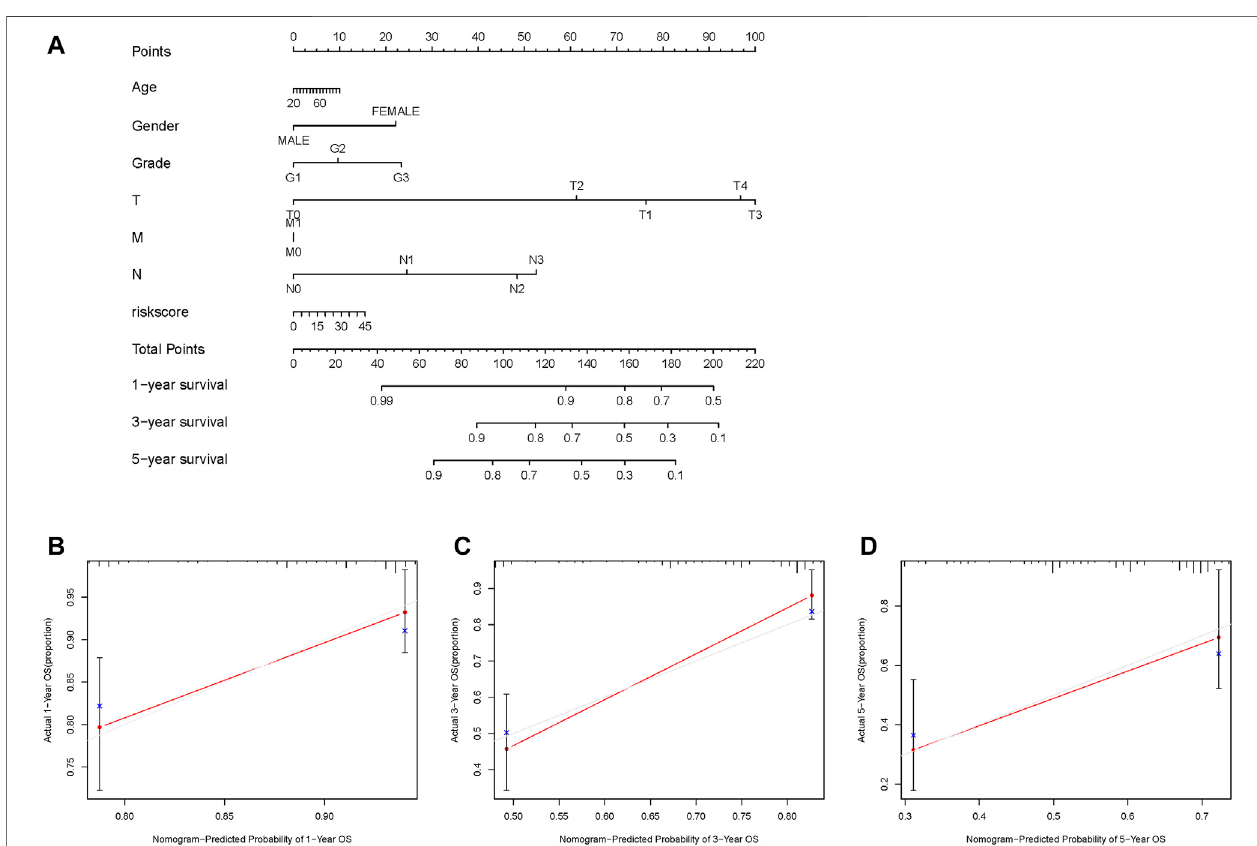
FIGURE 6 | Construction and evaluation of a nomogram based on the genome instability-related lncRNAs signature in the TCGA-HNSC cohort. (A) Development ofanomogrambasedontheGILncSigscore. (B – D) Calibration plotsforthesignatureat 1,3,and 5 years. GILncSig,genomicinstability-associated lncRNAs signature.